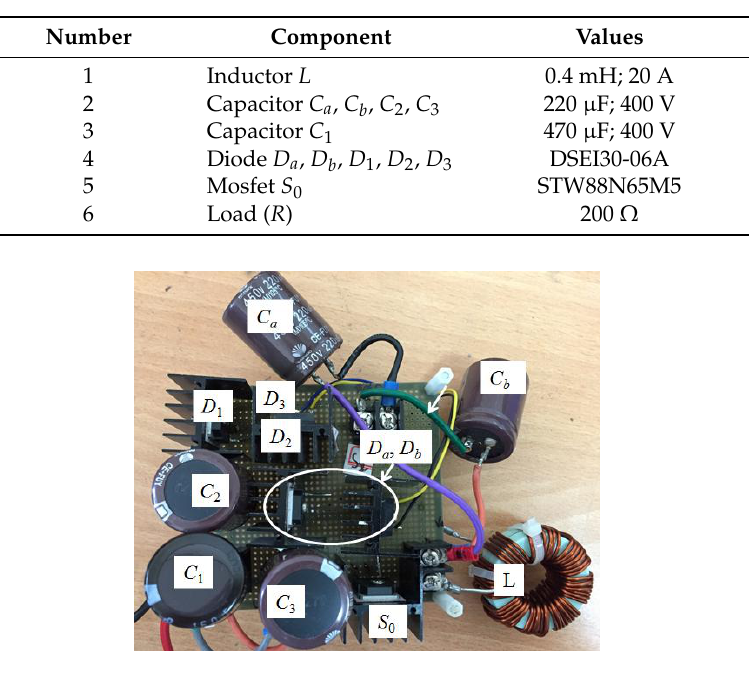
Figure 10. Prototype of the converter.